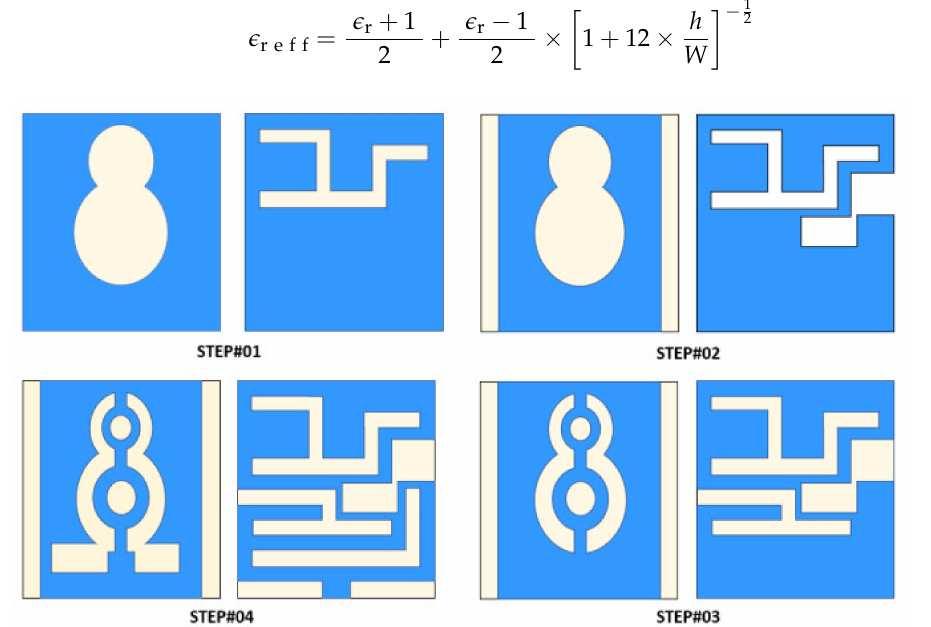
Figure 3. Designing steps of the stated implantable